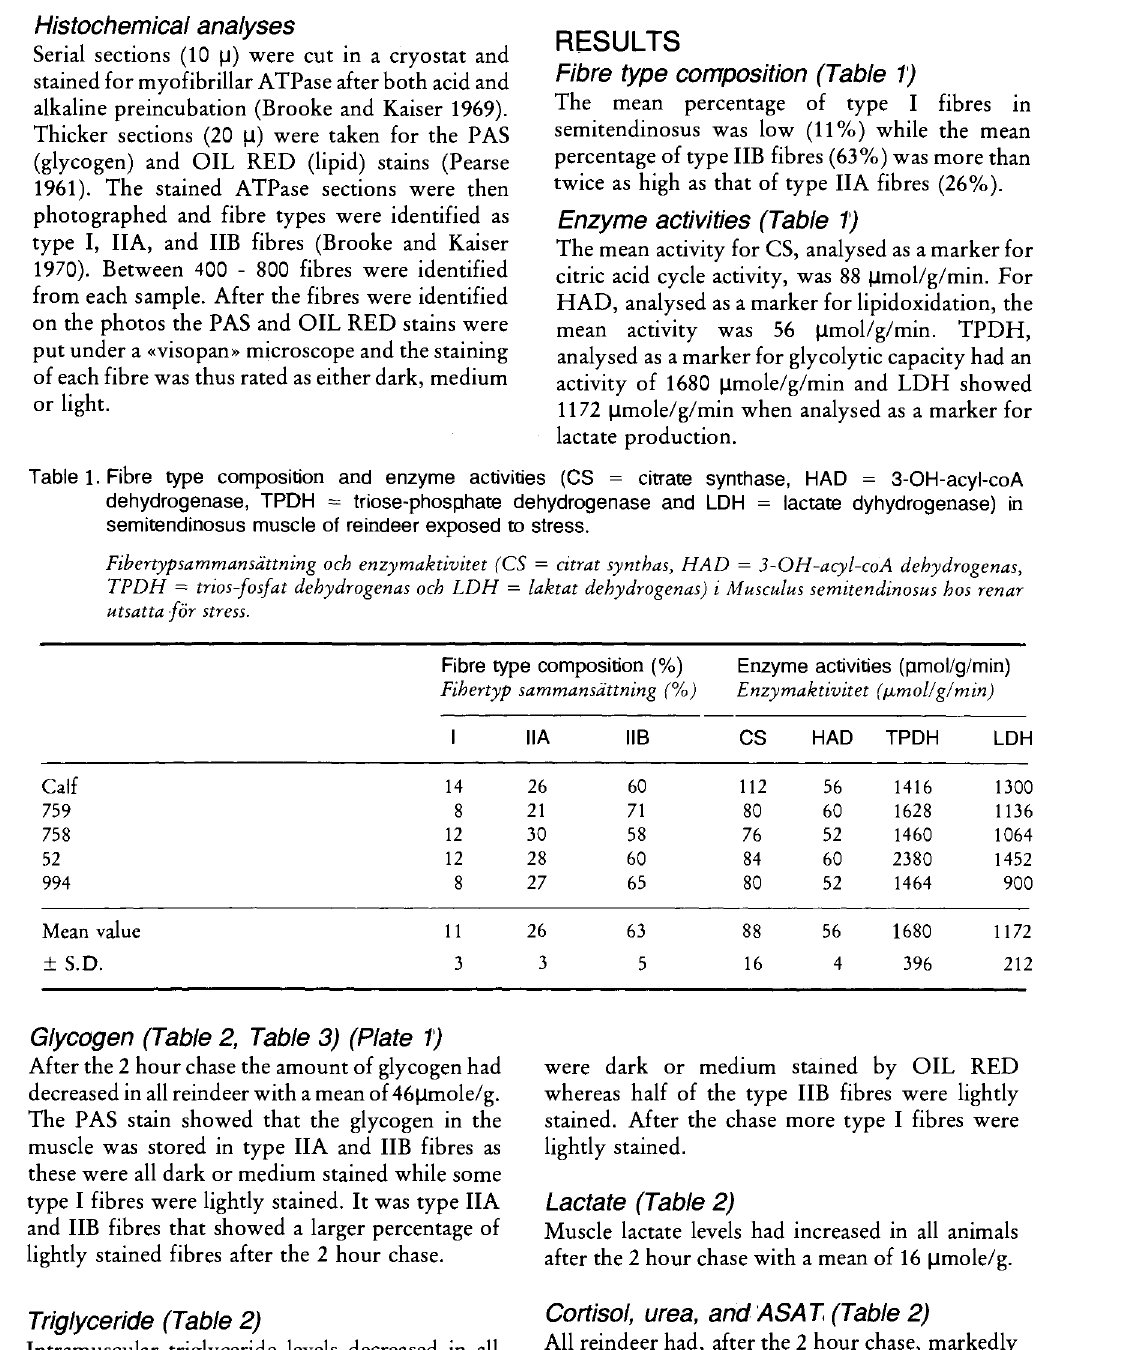
Table 1. Fibre type composition and enzyme activities (CS = citrate synthase, HAD = 3-OH-acyl-coA dehydrogenase, TPDH = triose-phosphate dehydrogenase and LDH = lactate dyhydrogenase) in semitendinosus muscle of reindeer exposed to